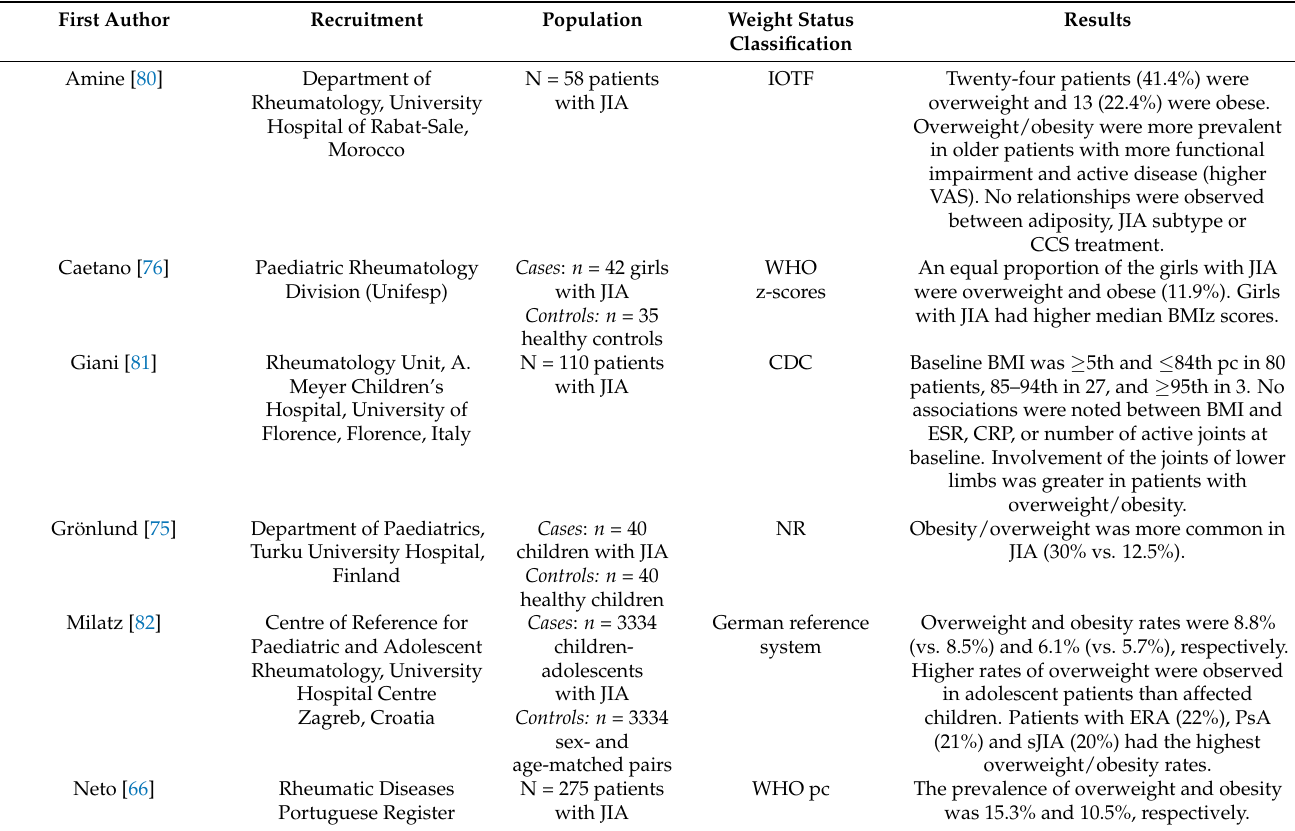
Table 2. Primary research on overweight and obesity among children with